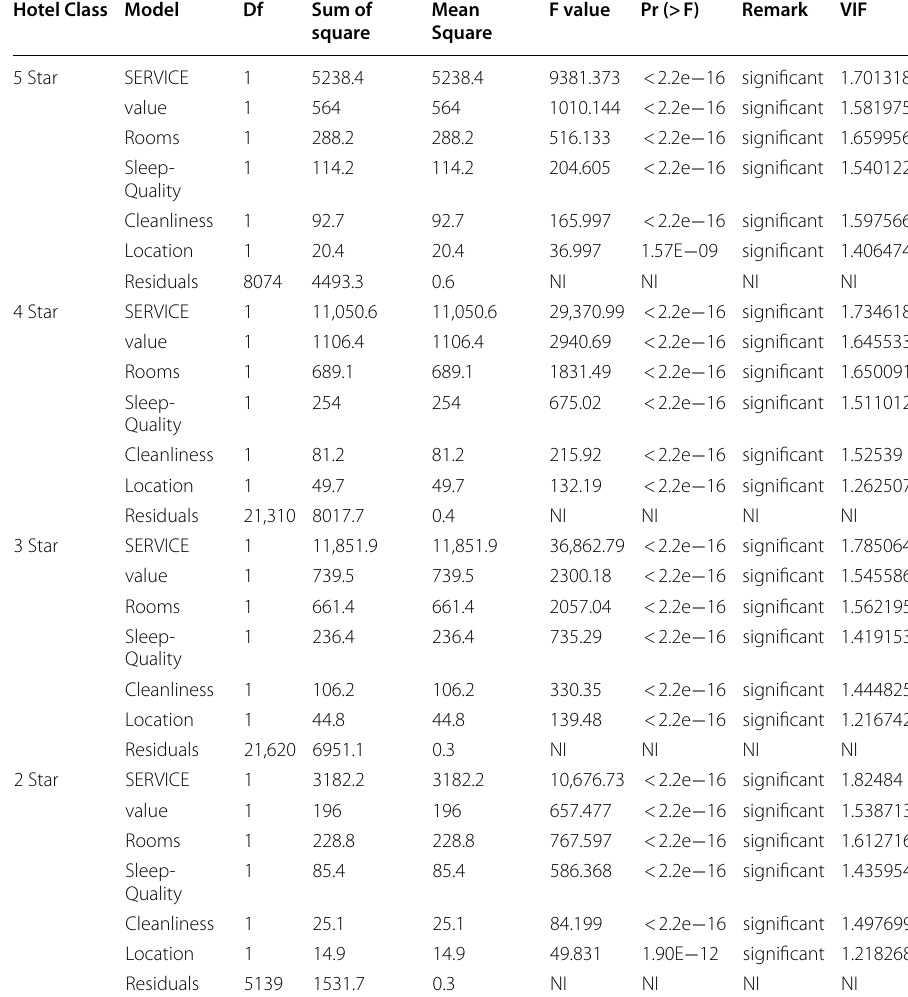
Table 8 Analysis of Variance (ANOVA) based on different hotel classes Hotel Class Model Df Sum of